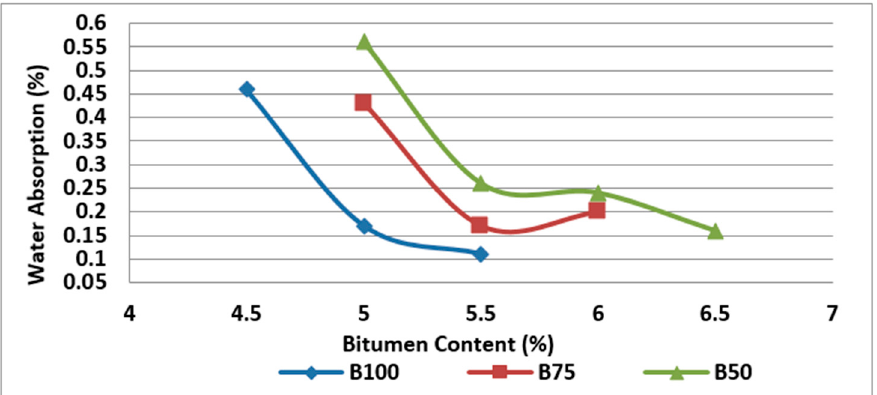
Figure 7. Effect of bitumen content and RCA content on water absorption of Mix I containing virgin aggregate and Mix II and Mix III containing RCA as coarse aggregate.